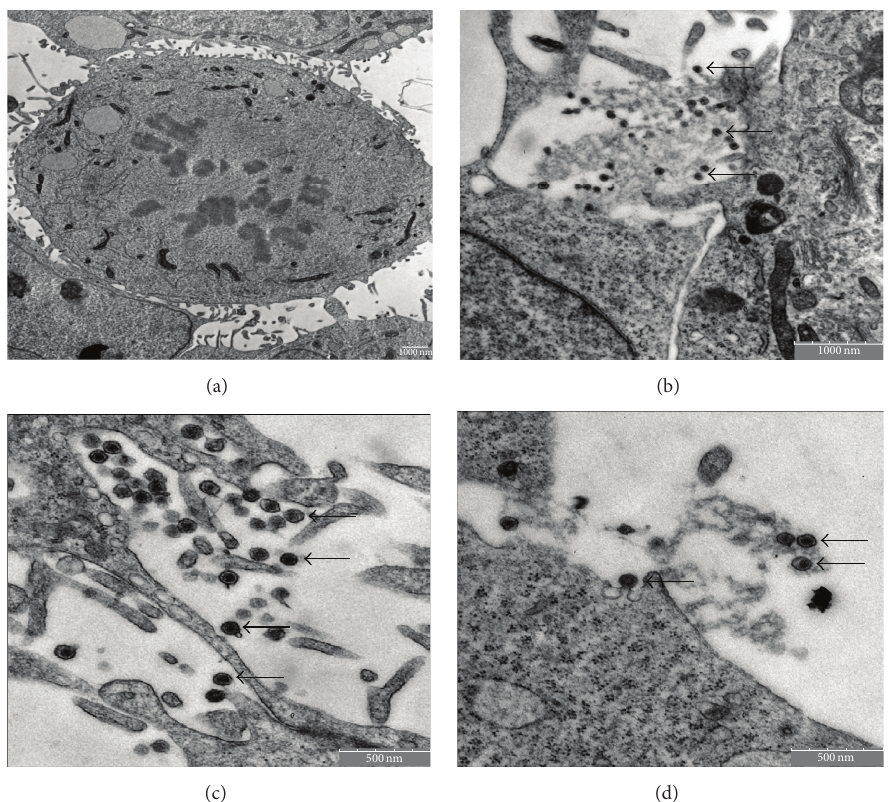
Figure1:Visualizationofsynovialsarcomacellsandmicrovesiclesby transmissionelectronmicroscopy(TEM).(a)Synovialsarcomacell.Bar indicating 1000 nm. ((b)–(d)) Close-up view which shows the release of microvesicles (arrows) by the synovial sarcoma cell. Bars indicating 1000 nm (b) and 500 nm ((c) and